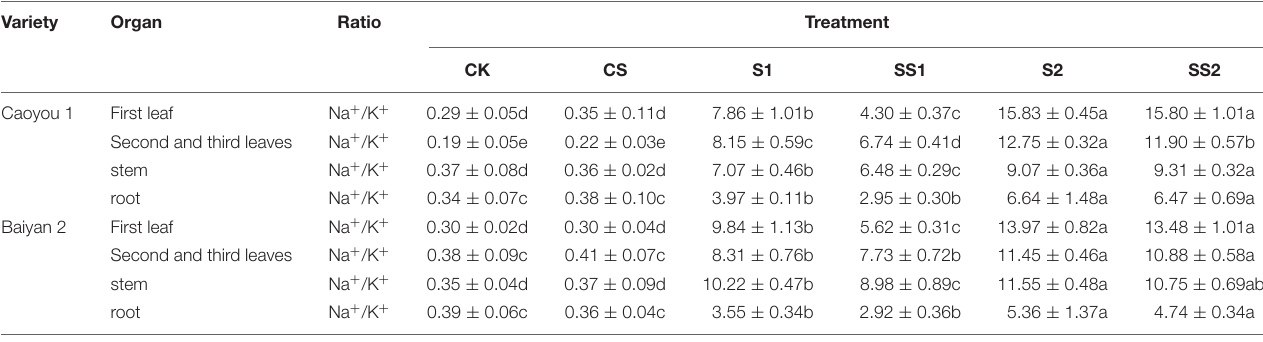
TABLE 1 | Effects of Spd application on Na + /K + ratio under salt stress in the oat seedlings. Variety